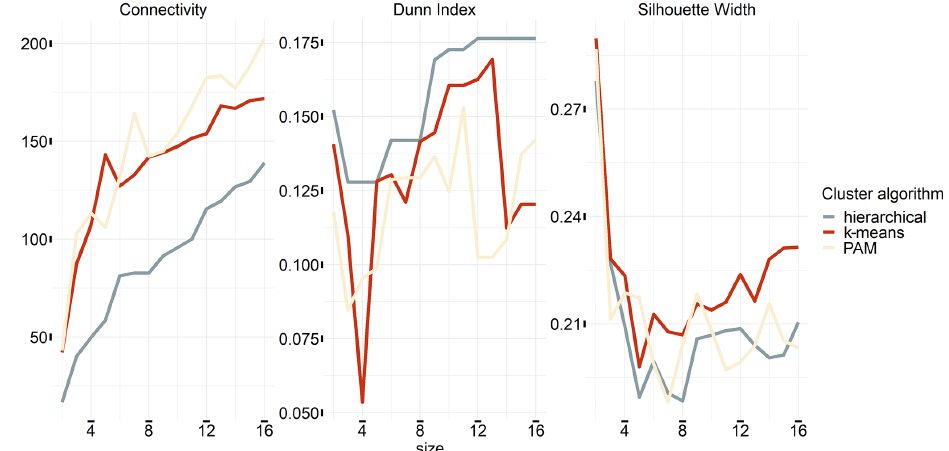
Figure A3. Internal validation measures for clusters with different sizes between 2 and 16. The measures depicted are connectivity, Dunn index, and silhouette width.